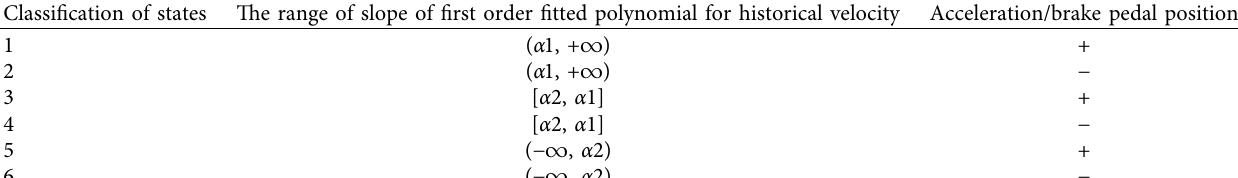
Figure 9: Power prediction-based MPC for energy management scheme. Table 1: Classification of state of input data.